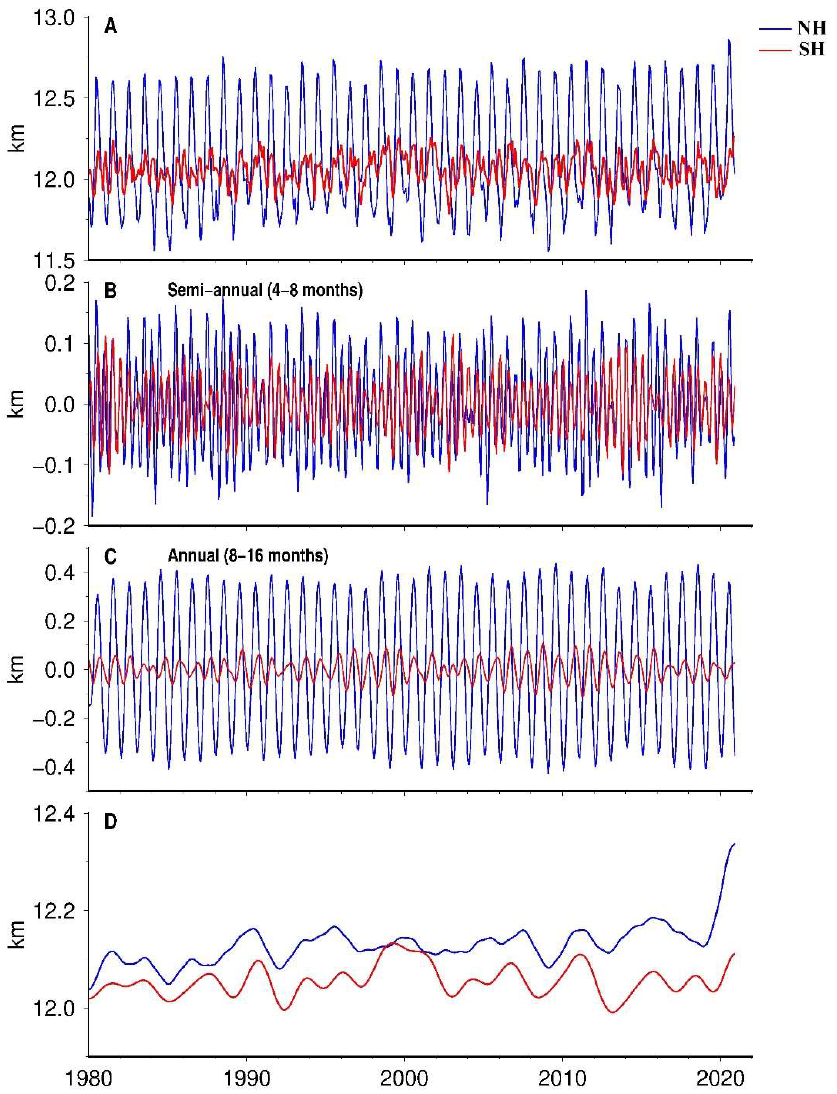
Figure 4. Decomposition of each time series (NH and SH) into different scales with corresponding frequency bands and a trend signal using the DWT method (using the 3.5 PVU surface as an example). ( A ): original time series (NH identified by a blue line and SH by a red line); ( B ): semi-annual variations; ( C ): annual variations; ( D ): trend signals.